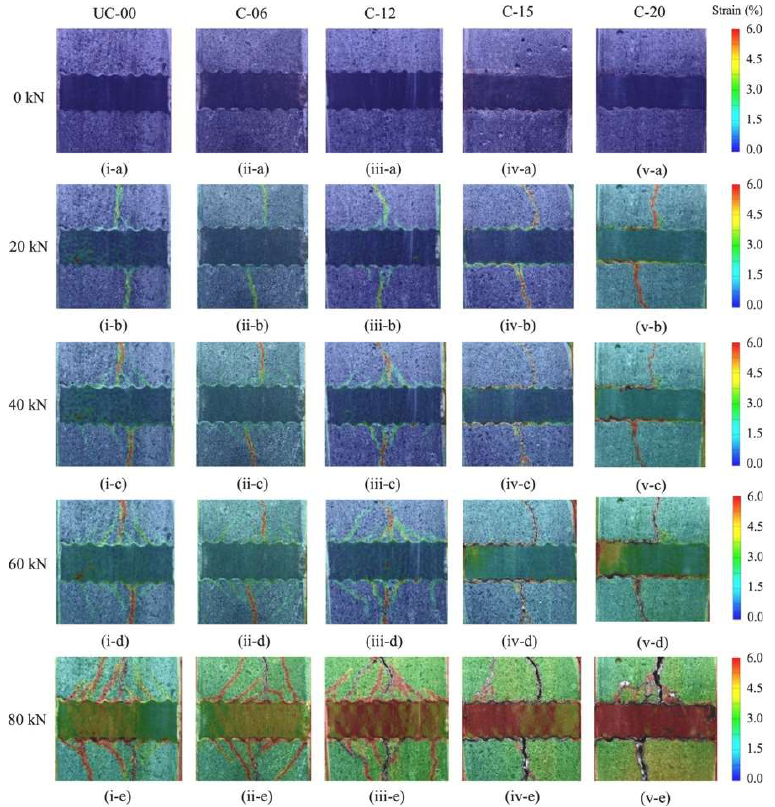
Figure 21. Change in strain distribution with loading. Reprinted with permission from [91]. 2021, Elsevier. Specimens UC-00, C-06, C-12, C-15, C-20 had degrees of corrosion of 0%, 6%, 12%, 15% and 20%,